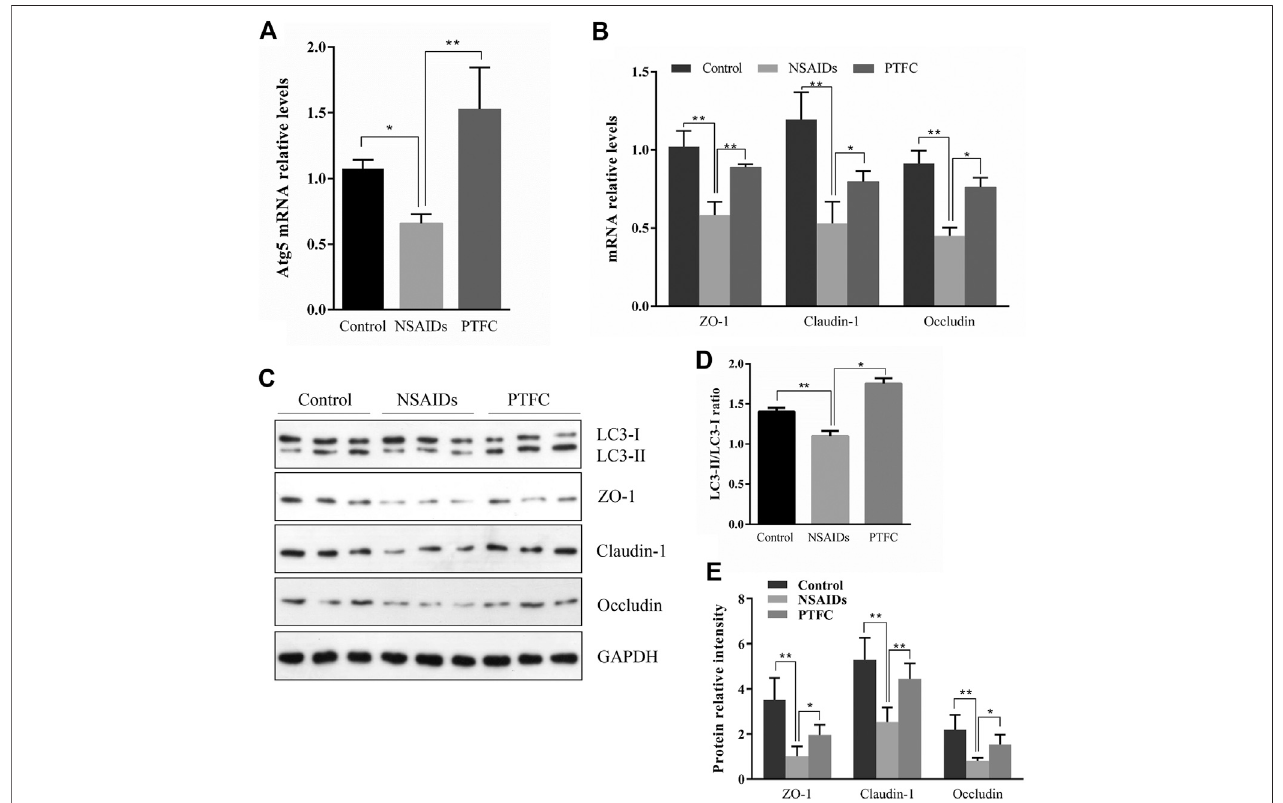
FIGURE 4 | PTFC increases TJ-related protein levels and inhibits NSAID-induced small intestine injury progression in rats. Levels of mRNA were evaluated in the NSAID model group, PTFC group, and control group of rats using quantitative reverse transcription-polymerase chain reaction (qRT-PCR) for (A) autophagy-related 5 (Atg5) and (B) ZO-1, CLDN1, and OCLN (C) Western blot analysis was used to determine protein expression levels in the groups of rats (D) Levels of light chain 3 (LC3) weredeterminedandthesignalintensityratioofLC3-II/LC3-IwascalculatedusingImageJsoftware(** p < 0.01) (E) ProteinexpressionofZO-1,CLDN1,andOCLN were measured in all groups using western blotting (* p < 0.05 and ** p <